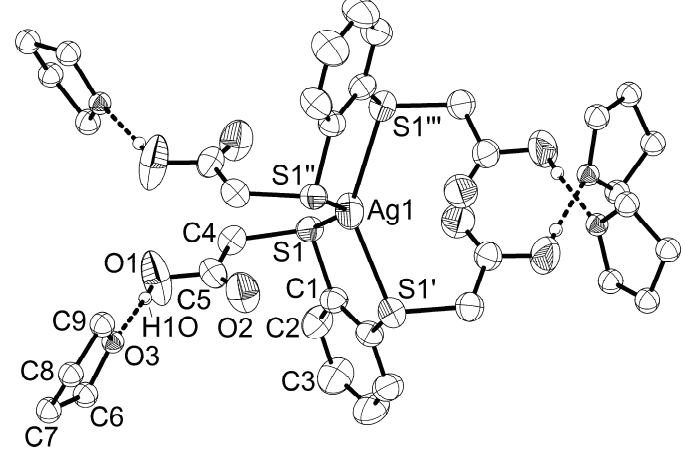
Figure 1. Molecular structure and atom labeling scheme for the silver complex cation in 1 . Each acetic acid proton (H1O) is hydrogen-bonded to a thf molecule. The BF 4 − anion, CH protons, and noncoordinating thf molecules are omitted for